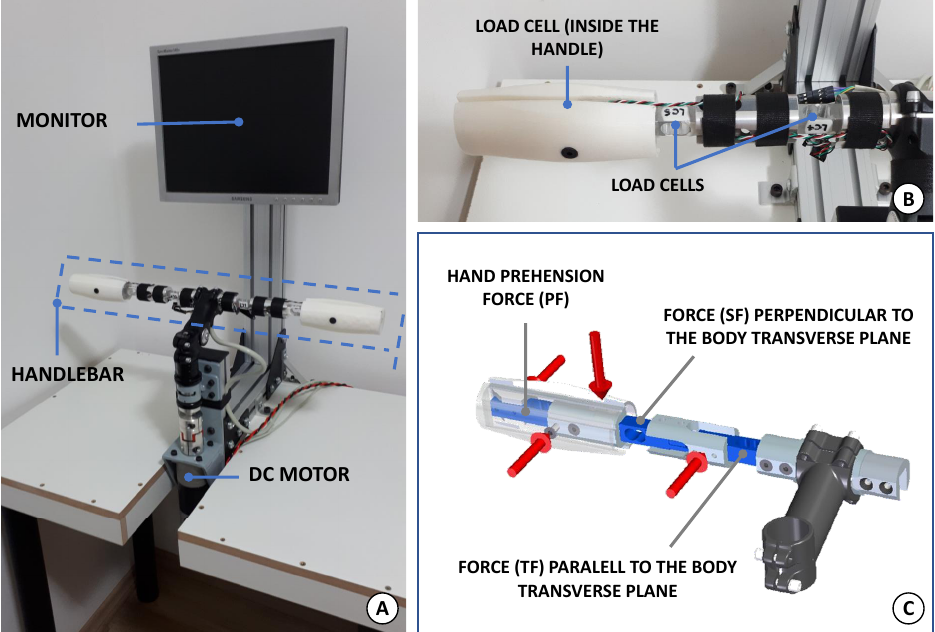
Figure 1. The developed handlebar-like system. ( A ) The instrumented handlebar, DC motor and the 15” monitor are supported with a frame of aluminium profile. ( B ) Left side of the handlebar showing three load cells, mounted in different positions and orientations. ( C ) Each load cell has a specific mount position and orientation to record the different